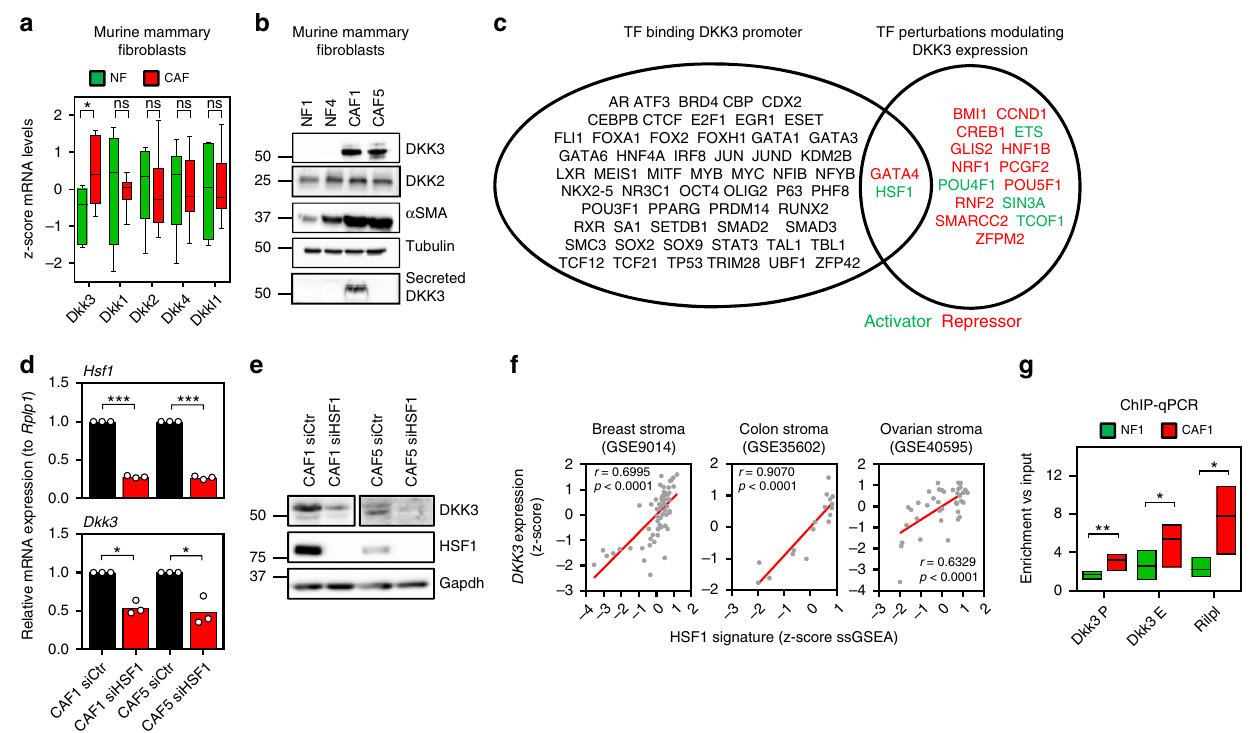
Fig. 2 DKK3 is a HSF1 target gene associated with CAF emergence. a Tukey boxplots showing z-score values of Dickkopft genes mRNA expression in murine mammary NFs and CAFs (NF, n = 6; CAF, n = 8). b Western blot showing protein levels of DKK3, DKK2, α SMA and tubulin in total lysates of two sets of murine mammary NFs and PyMT-CAFs. Levels of secreted DKK3 are also shown. c Venn diagram showing the overlap between transcription factors (TFs) known to bind the DKK3 promoter (left) and TFs whose perturbation modulates DKK3 expression levels (right). In red, TFs that negatively affect DKK3 expression; in green, TFs that positively affect DKK3 expression. d Graphs show Hsf1 and Dkk3 fold mRNA expression levels (relative to Rplp1 ) in murine PyMT-CAFs (CAF1 and CAF5) after transfection with control or Hsf1 siRNAs (smart-pool). Bars show mean value ± SEM ( n = 3). e Western blots show Hsf1, Dkk3 and Gapdh expression in murine PyMT-CAFs (CAF1 and CAF5) after transfection with control or Hsf1 siRNAs (smart-pool). ( f ) Graphs show correlations between DKK3 gene expression and HSF1 activity as measured by the expression of HSF1 gene signature (z-score normalised) in stroma of breast, colorectal and ovarian cancers. Pearson correlation coef fi cient ( r ) is shown. Each dot represents z-score values from individual samples. g Graph shows binding of Hsf1 to regulatory elements in the Dkk3 gene (DKK3 P – promoter; DKK3 E – enhancer) in murine NF1 and CAF1. Primers targeting the bona fi de Hsf1 target gene Rilpl were used as a positive control. Floating boxes: centre line, mean; box limits, min and max values (normalised to DNA amount)( n = 3). Where indicated, individual p values are shown; alternatively the following symbols were used to describe